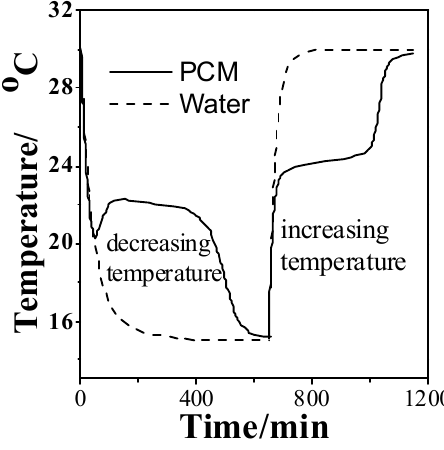
Figure 2. Endothermic and exothermic performance of PCM.